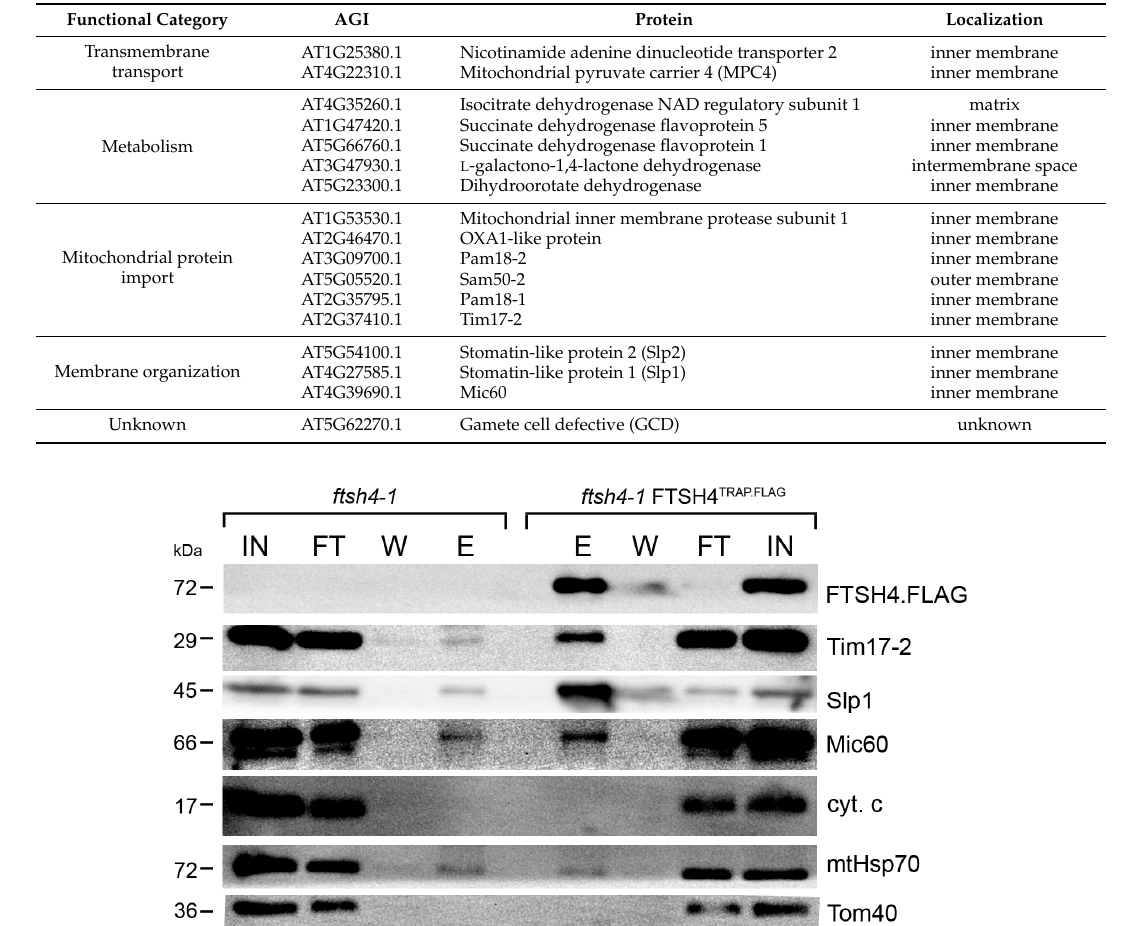
Table 1. Proteins co-purifying with FTSH4 TRAP.FLAG . Listed are all proteins that were specifically co-purifying with proteolytically inactive FTSH4 (proteins enriched at least two times in two independent biological replicates over the background samples (Table S1)). Functional categories and mitochondrial sub-localization were assigned based on the Uniprot database and the literature. AGI— Arabidopsis Gene ID.